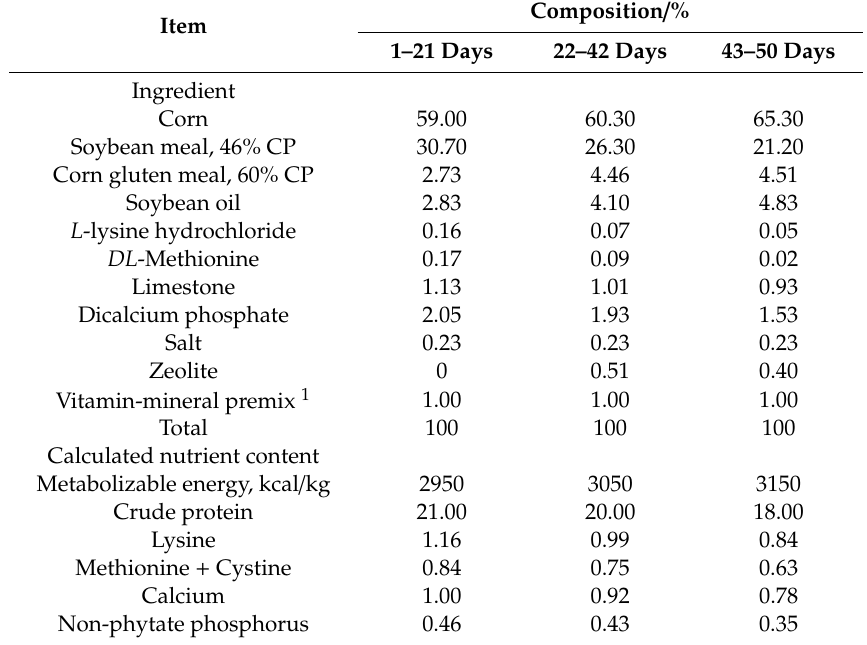
Table 1. Ingredient and nutrient levels of the basal diets in each feeding phase for yellow broilers (g / kg, as-fed basis unless otherwise